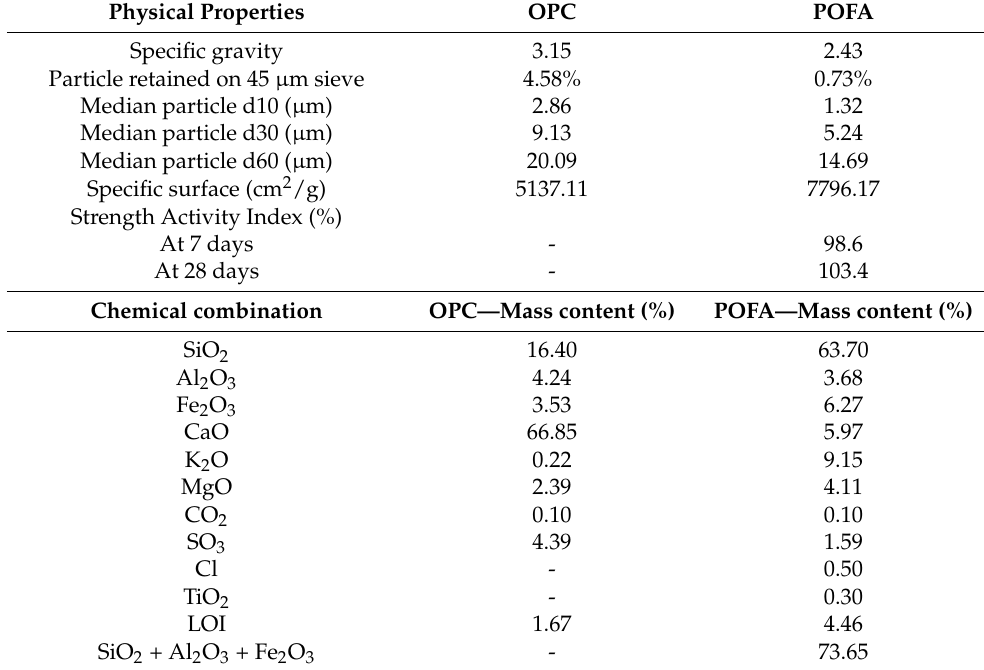
Table 1. Physical and chemical properties of OPC and POFA.